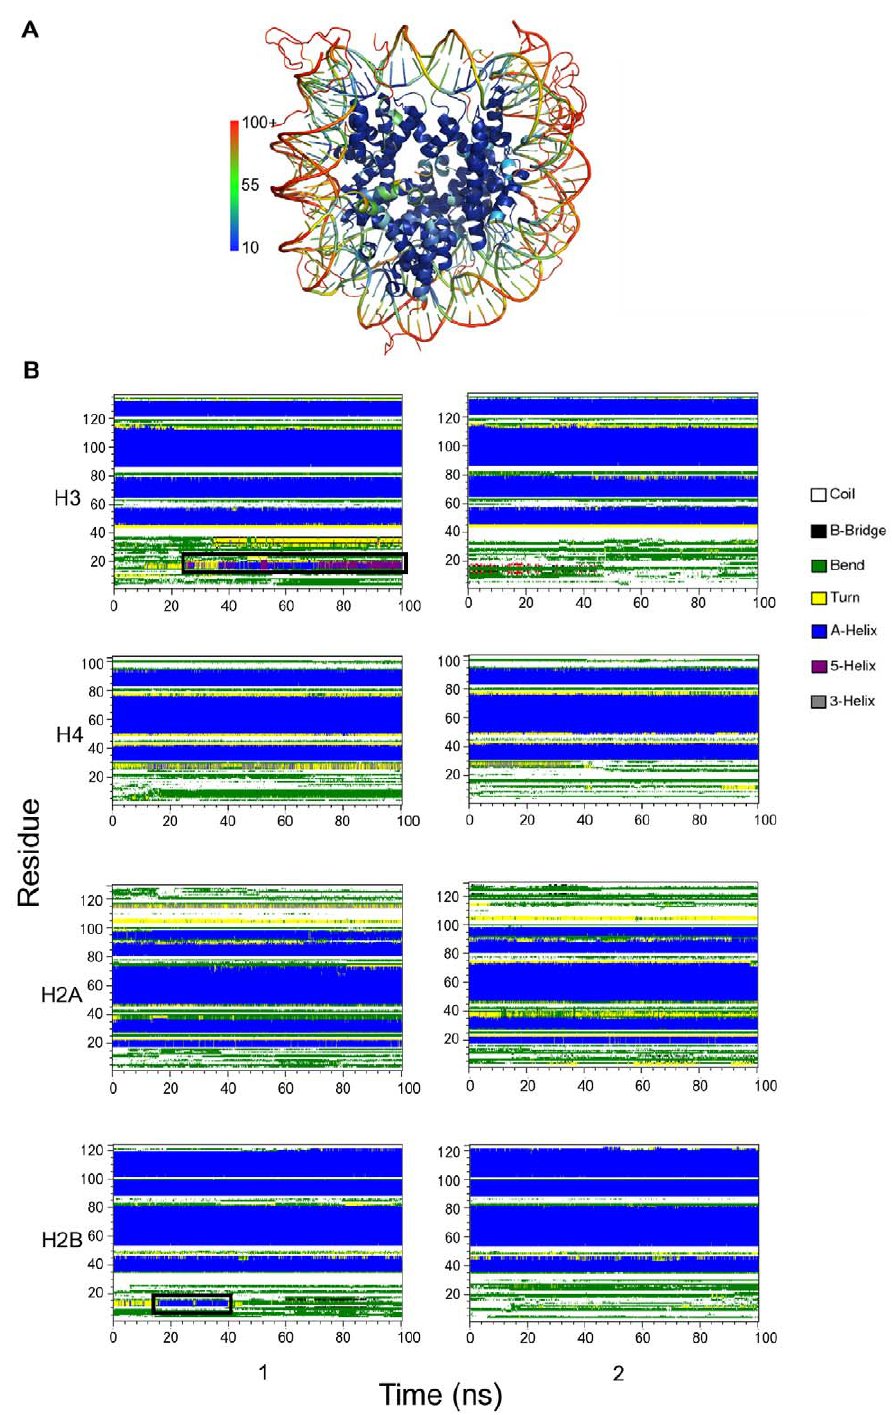
Figure 3. Structural fluctuations in the nucleosome. (A) Temperature factor of the nucleosome in cartoon representation. The atoms are colored as indicated in the scale. (B) Secondary structure of the histone calculated using the dssp program [45]. During the simulation amino acids 14–20 of H3 (copy 1) and amino acids 11–15 of H2B (copy 1) show propensity to form a -helices. molecule [19]. The DNA helical parameter fluctuations are also in bases (Gua98(I)-Cyt50(J)) show unusual (non Watson-Crick) base- good agreement with those extracted from the crystal structure pairing in the intact nucleosome simulation. However, this did not (Supplementary Fig. S2). lead to any unusual fluctuation in the neighboring amino-acid residues. Furthermore, since the DNA backbone and helical While analyzing the DNA dihedral parameters we did find that parameter values derived from all other base pairs are in one nucleotide base (Cyt49(J)) is unstacked and the neighboring